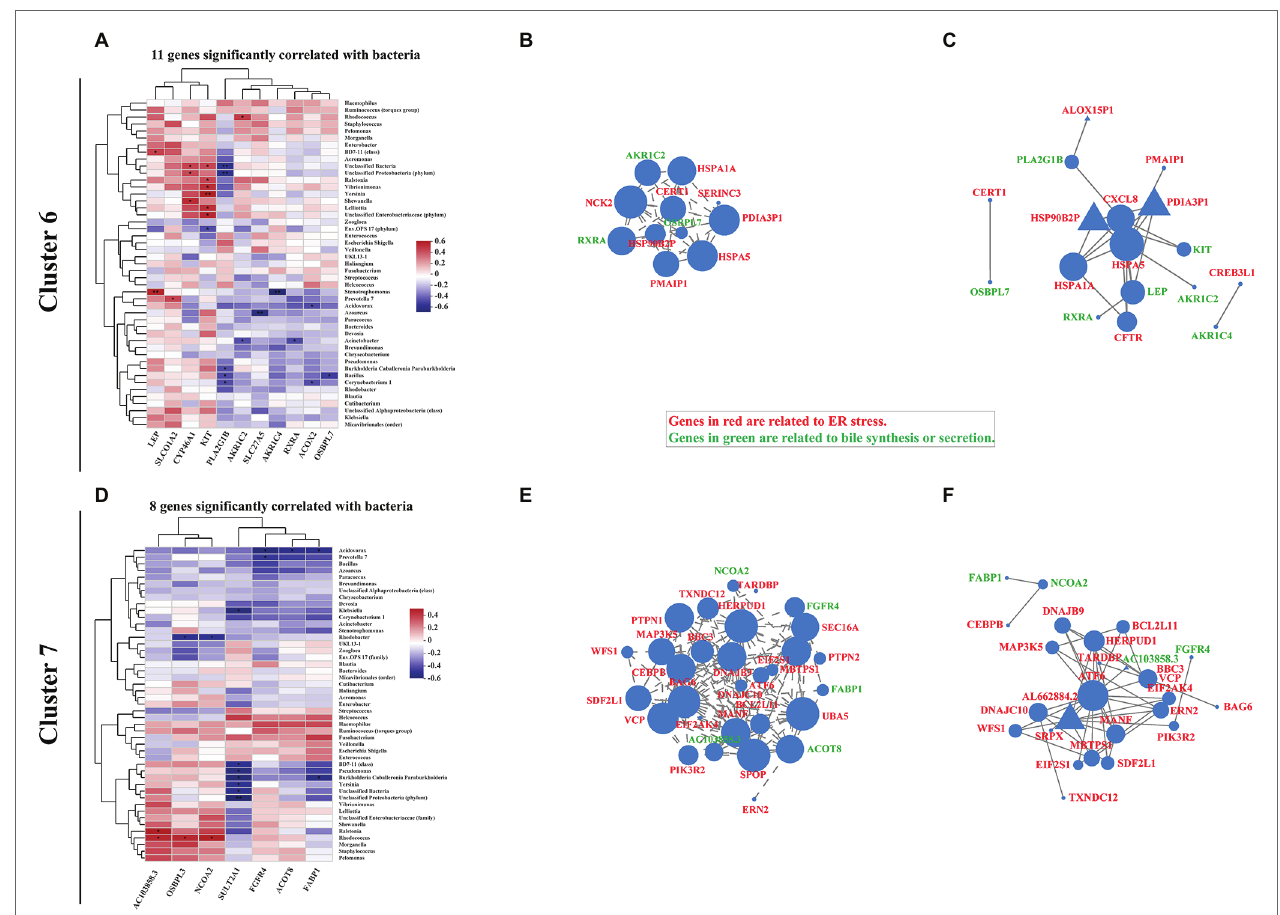
FIGURE 5 | Correlation pattern of bile acid production with intestinal mucosa-colonizing bacteria community and ER stress in IBD patients. Spearman correlation heatmap shows 11 bile-related genes in cluster 6 (A) and eight bile-related genes in cluster 7 (D) were significantly correlated with intestinal mucosa-colonizing bacteria (top 47). All bacteria were named to genus level unless otherwise noted in brackets. * 0.01 < p ≤ 0.05, ** 0.001 < p ≤ 0.01, and *** p ≤ 0.001. Correlation network of both ER stress- and bile acid production-related genes in cluster 6 (B) and cluster 7 (E) . ER stress- and bile acid production-related genes are labeled in red and green, respectively. Circle area is positively correlated with number of connected genes. Correlation network was constructed based on Spearman rank correlation coefficients ( ∣ Spearman Coef ∣ ≥ 0.8, p < 0.05). Multiple testing correction: BH. Interaction network of ER stress- and bile acid production-related genes in cluster 6 (C) and cluster 7 (F) . Circle or equilateral triangle areas are positively correlated with number of connected genes. Interaction between circle-labeled genes with others has been reported. Interaction between equilateral triangle-labeled genes with others was predicted based on primary structure of gene-coding proteins. Control population: n = 6; UC patient: n = 12; and CD patient: n =